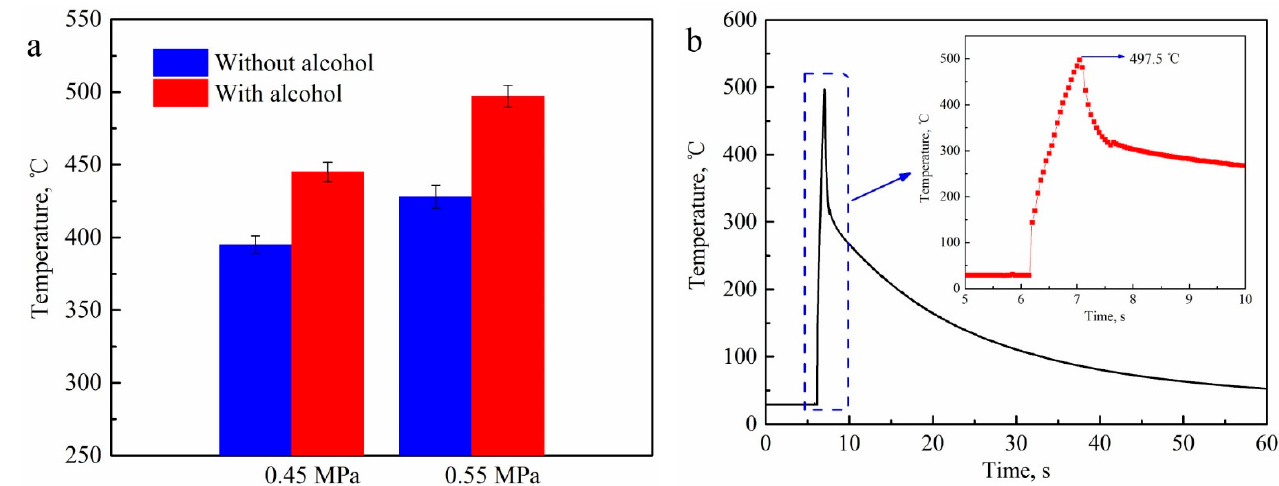
Figure 4. Welding interface temperature of the joints without and with alcohol at 0.45 MPa and 0.55 MPa welding pressures ( a ) and the representative welding interface temperature profile for the joint with alcohol at 0.55 MPa welding pressure ( b